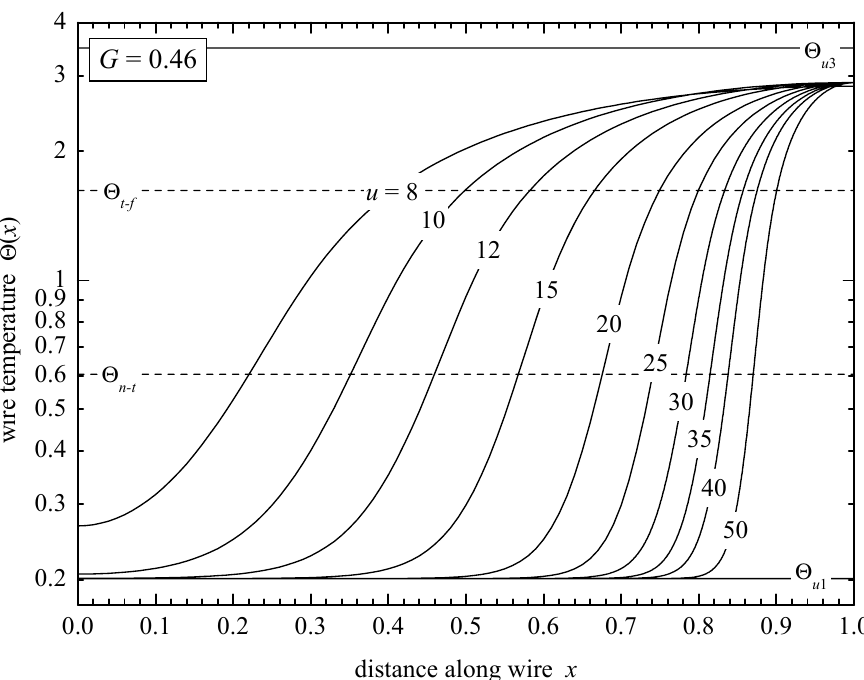
Θ ( x ) as a function of u for G = 0.46. 2